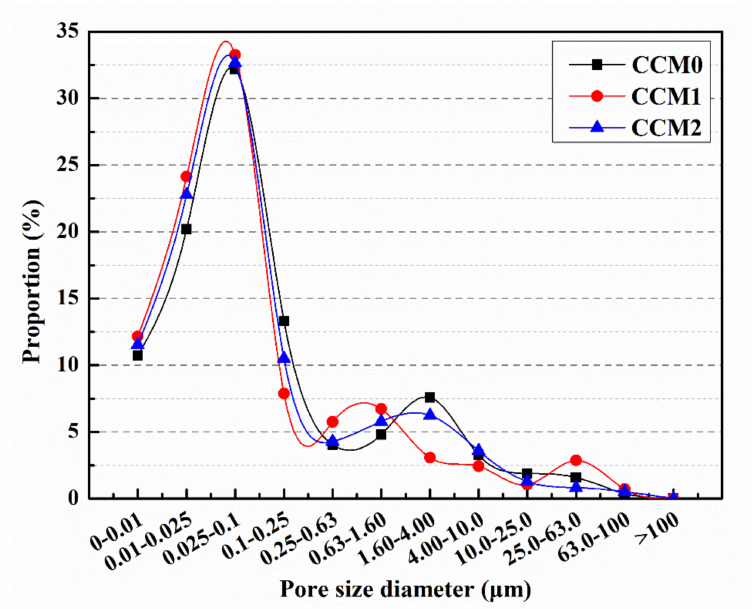
Figure 10. Pore size distribution of